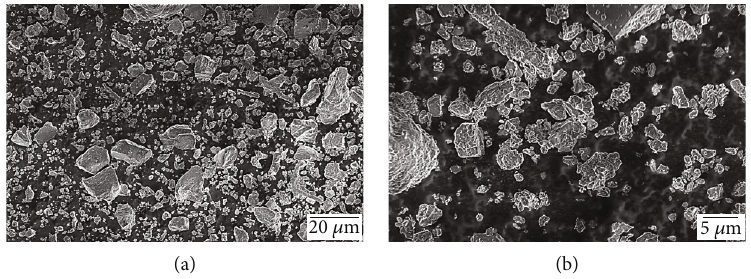
Figure 2: SEM images of ES particles: (a) an overview and (b) detailed view of the surface